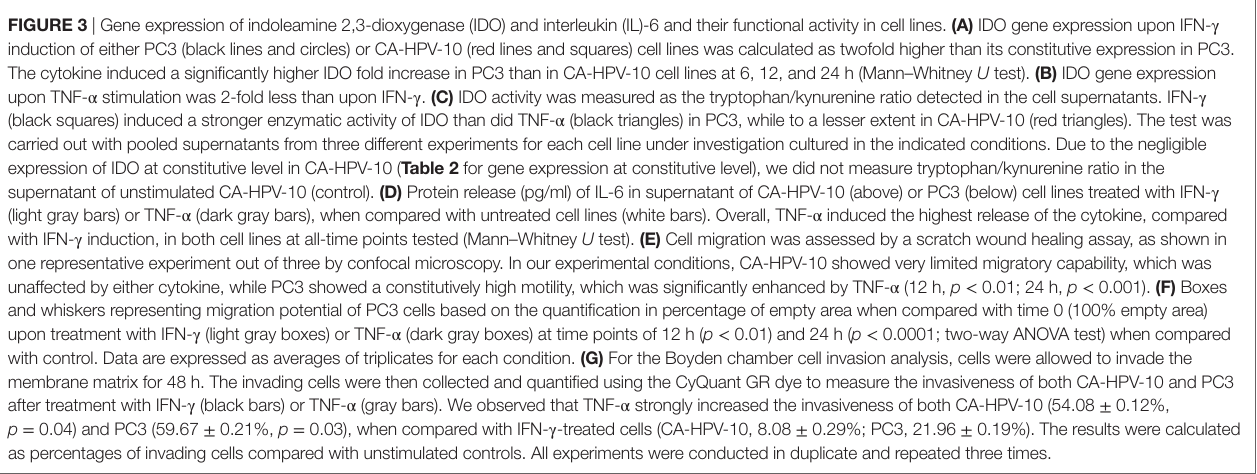
FigUre 3 | Gene expression of indoleamine 2,3-dioxygenase (IDO) and interleukin (IL)-6 and their functional activity in cell lines. (a) IDO gene expression upon IFN- γ induction of either PC3 (black lines and circles) or CA-HPV-10 (red lines and squares) cell lines was calculated as twofold higher than its constitutive expression in PC3. The cytokine induced a significantly higher IDO fold increase in PC3 than in CA-HPV-10 cell lines at 6, 12, and 24 h (Mann–Whitney U test). (B) IDO gene expression upon TNF- α stimulation was 2-fold less than upon IFN- γ . (c) IDO activity was measured as the tryptophan/kynurenine ratio detected in the cell supernatants. IFN- γ (black squares) induced a stronger enzymatic activity of IDO than did TNF- α (black triangles) in PC3, while to a lesser extent in CA-HPV-10 (red triangles). The test was carried out with pooled supernatants from three different experiments for each cell line under investigation cultured in the indicated conditions. Due to the negligible expression of IDO at constitutive level in CA-HPV-10 ( Table 2 for gene expression at constitutive level), we did not measure tryptophan/kynurenine ratio in the supernatant of unstimulated CA-HPV-10 (control). (D) Protein release (pg/ml) of IL-6 in supernatant of CA-HPV-10 (above) or PC3 (below) cell lines treated with IFN- γ (light gray bars) or TNF- α (dark gray bars), when compared with untreated cell lines (white bars). Overall, TNF- α induced the highest release of the cytokine, compared with IFN- γ induction, in both cell lines at all-time points tested (Mann–Whitney U test). (e) Cell migration was assessed by a scratch wound healing assay, as shown in one representative experiment out of three by confocal microscopy. In our experimental conditions, CA-HPV-10 showed very limited migratory capability, which was unaffected by either cytokine, while PC3 showed a constitutively high motility, which was significantly enhanced by TNF- α (12 h, p < 0.01; 24 h, p < 0.001). (F) Boxes and whiskers representing migration potential of PC3 cells based on the quantification in percentage of empty area when compared with time 0 (100% empty area) upon treatment with IFN- γ (light gray boxes) or TNF- α (dark gray boxes) at time points of 12 h ( p < 0.01) and 24 h ( p < 0.0001; two-way ANOVA test) when compared with control. Data are expressed as averages of triplicates for each condition. (g) For the Boyden chamber cell invasion analysis, cells were allowed to invade the membrane matrix for 48 h. The invading cells were then collected and quantified using the CyQuant GR dye to measure the invasiveness of both CA-HPV-10 and PC3 after treatment with IFN- γ (black bars) or TNF- α (gray bars). We observed that TNF- α strongly increased the invasiveness of both CA-HPV-10 (54.08 ±